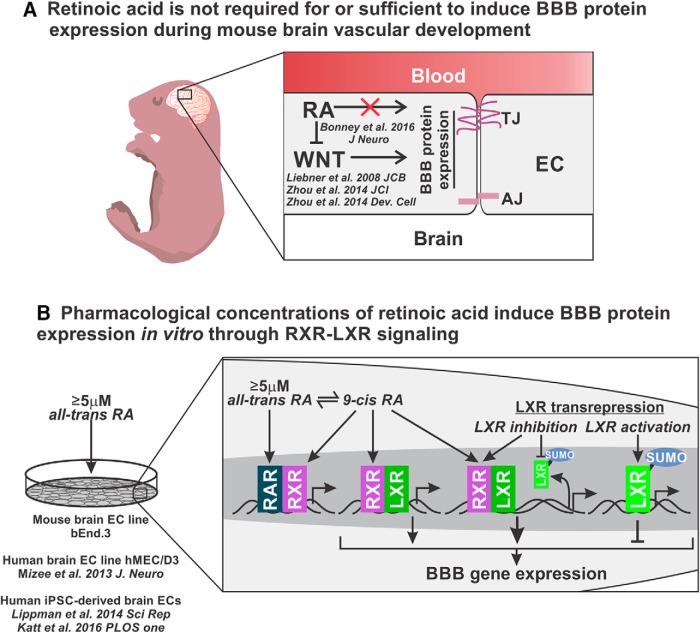
A, Our studies using RA-deficient embryos (Rdh10 mutants) and atRA-exposed embryos revealed that RA is not required for or capable of enhancing BBB protein expression within the developing brain vasculature. Conversely, multiple studies show that endothelial WNT signaling is required for BBB protein expression by the developing brain vasculature (Liebner et al. 2008; Zhou and Nathans 2014; Zhou et al. 2014). A recent study also showed that RA inhibits endothelial WNT signaling, further supporting that RA does not function to promote BBB development (Bonney et al. 2016). B, Recent studies have used pharmacological doses of atRA to induce BBB gene expression in human brain ECs (Mizee et al. 2013) and iPSC-derived brain ECs (Katt et al. 2016; Lippmann et al. 2014). Here we show the same effect occurs in the murine brain endothelioma cell line, b.End3 cells. Pharmacological concentrations of atRA, which activates RAR/RXR signaling, can also isomerize to 9cRA and activate the LXR/RXR signaling pathway. We also show that 9cRA is capable of inducing BBB gene expression and LXR/RXR signaling in the b.End3 cells. In our studies to identify how LXRs are involved in BBB gene regulation, we found that activation of LXR signaling using T0901317 results in the down-regulation of BBB genes. This effect may act through LXR transrepression in which LXR monomers become SUMOylated and recruit transcriptional corepressors to the promoter of BBB genes. Inhibition of LXR signaling with GSK-2033 reduces LXR SUMOylation and may relieve the LXR transrepression of BBB genes, which enhances the LXR/RXR-mediated up-regulation of BBB genes. Additionally, GSK-2033 can induce RXR transcriptional activity, thus potentially promoting the expression of BBB genes (Griffett and Burris 2016).